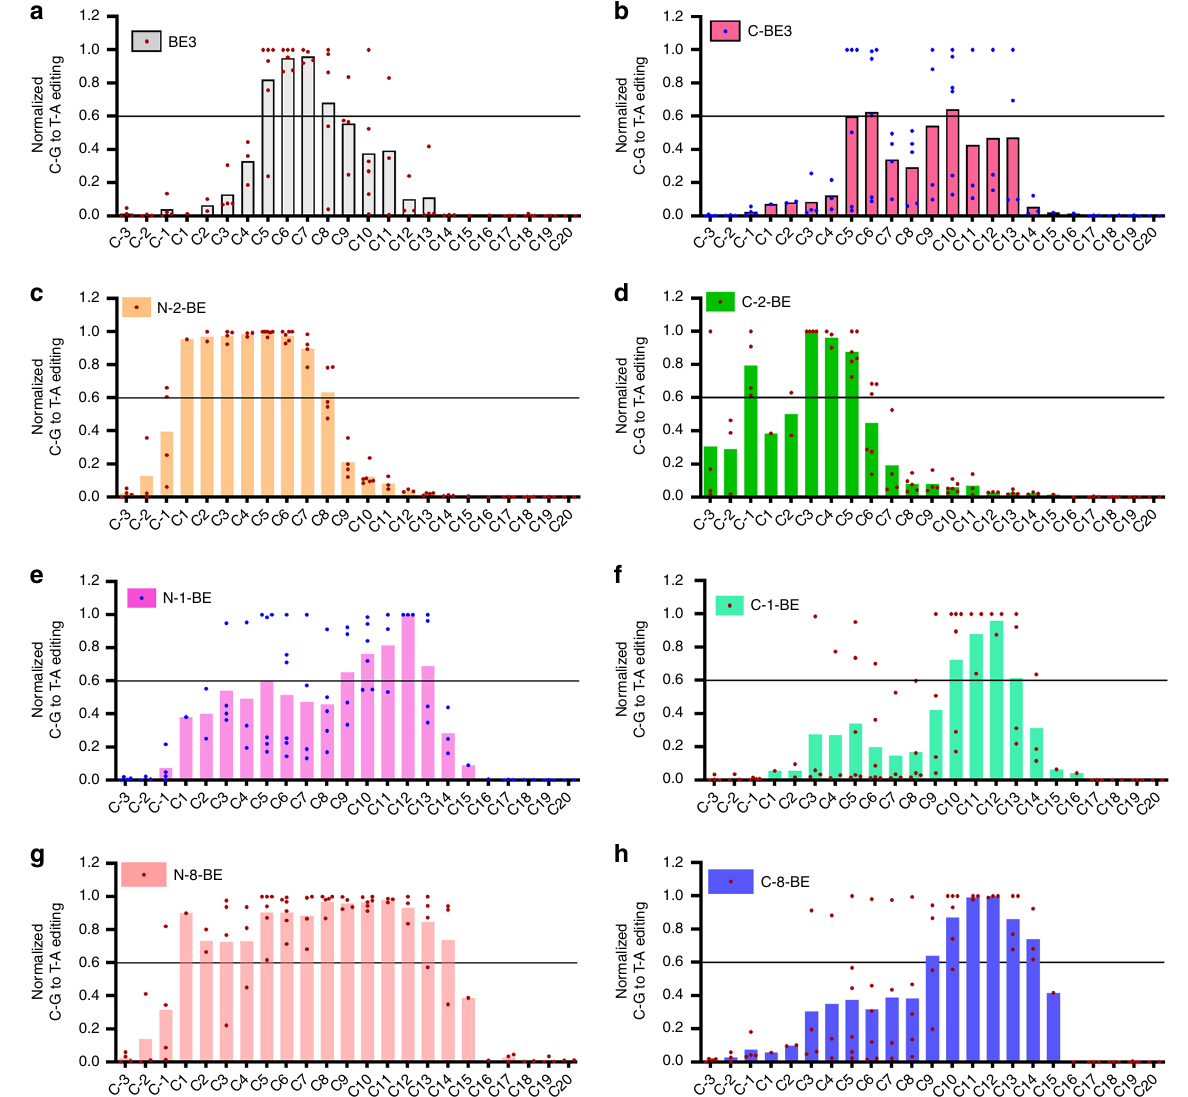
Fig. 5 Comprehensive editing windows of functional CBEs. a – h Normalized C – T conversion ef fi ciency across 9 different sgRNAs for BE3 a , C-BE3 b , N-2-BE c , C-2-BE d , N-1-BE e , C-1-BE f , N-8-BE g and C-8-BE h . Source data are provided as a Source Data fi